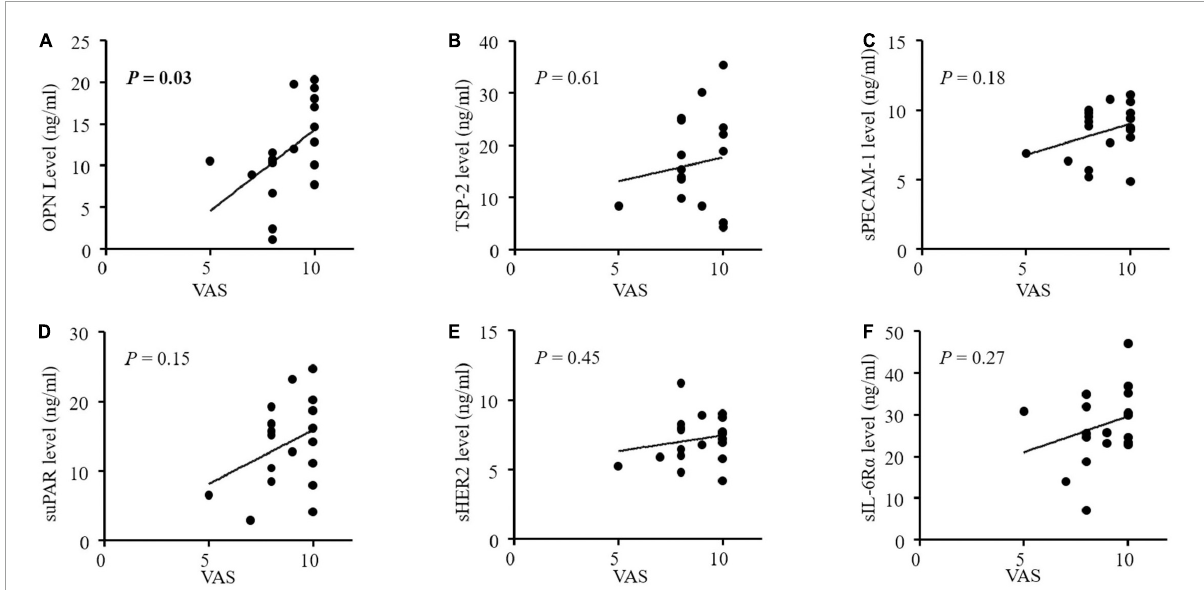
FIGURE3 (A-F) Correlations between concentrations of angiogenic factors and pain intensity by VAS in patients with postherpetic neuralgia (PHN). Only serum OPN levels were significantly correlated with VAS in PHN patients ( P = 0.03). OPN, osteopontin; TSP-2, thrombospondin-2; sPECAM-1, soluble platelet endothelial cell adhesion molecule-1; suPAR, soluble urokinase-type plasminogen activator receptor; s ErbB2, soluble human epidermal growth factor receptor 2; sIL-6R α , soluble interleukin-6 receptor α ; VAS, visual analog scale.